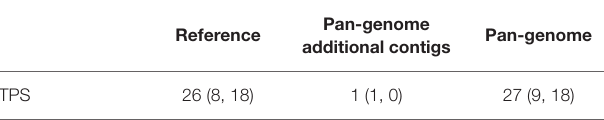
TABLE 2 | The number of Terpene synthase (TPS) found on the reference genomes and pan-genome additional contigs.